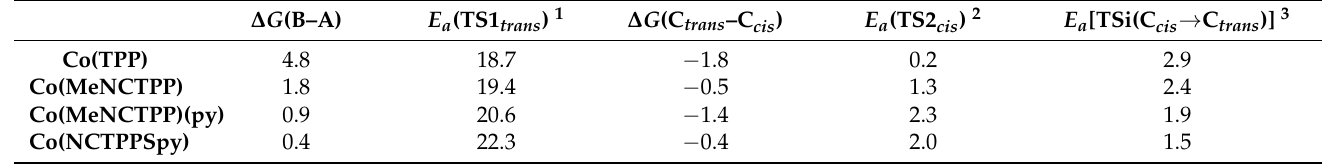
Table 2. The calculated Gibbs free energies ∆ G and activation energy E a (in